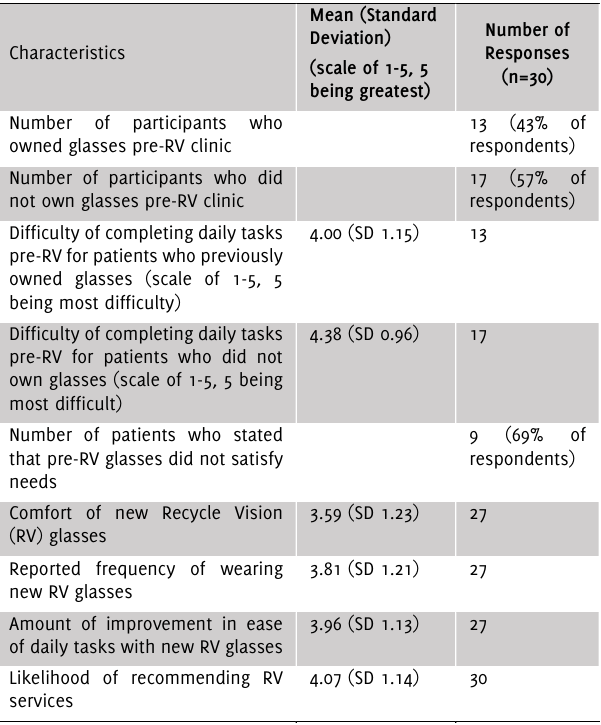
Table 1 . Compiled Clinic Survey Results.